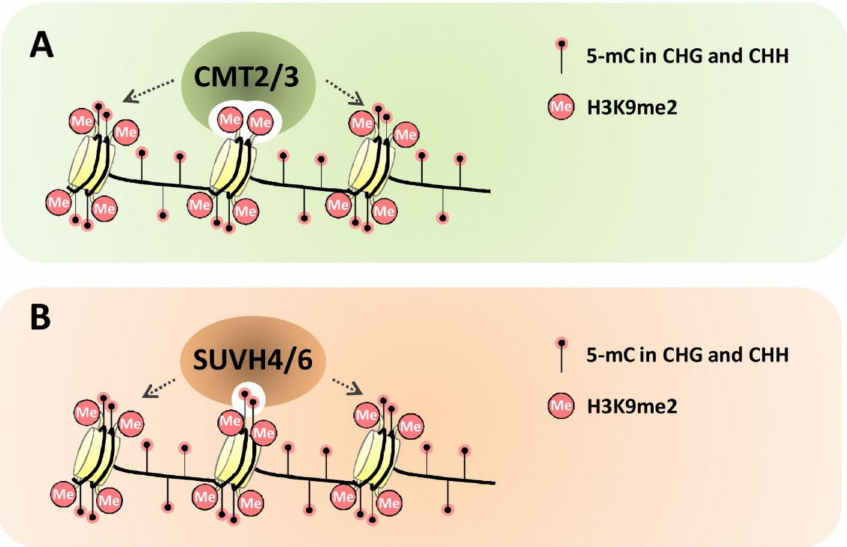
Figure 1. Simplified models for the DNA and histone methylation mediated by DNA methyltrans- ferases CMT2/3 and histone H3K9 methyltransferases SUVH4/6. ( A ) Arabidopsis DNA methyl- transferases CMT2/3 contain H3K9me2 binding sites and directly link non-CG DNA methylation and histone H3K9me2. ( B ) Arabidopsis histone H3K9 methyltransferases SUVH4/6 contain methy- lated DNA binding sites, thereby mediating the cross-regulation of non-CG DNA methylation and histone